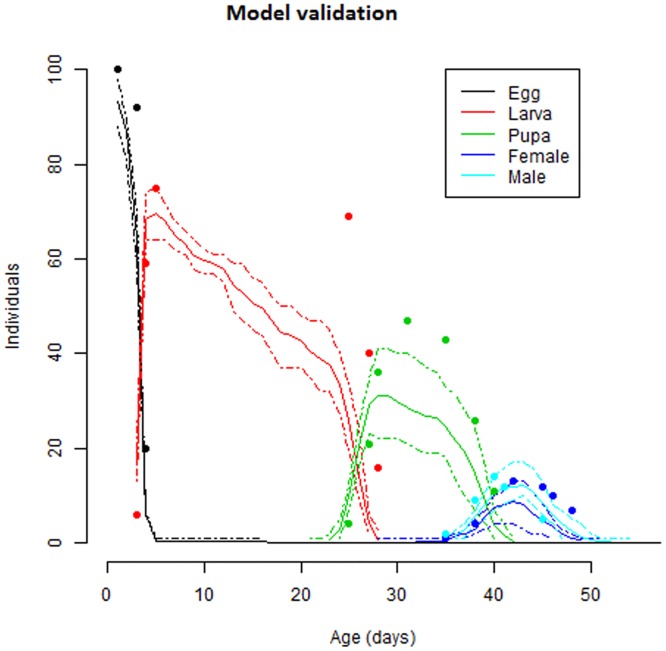
Model validation.Observed and simulated life stage frequencies of S. litura. Dots represent observed data points at fluctuating experiments, and the lines represent developmental frequencies simulated at fluctuating temperatures based on thermal reaction norms for constant temperatures.